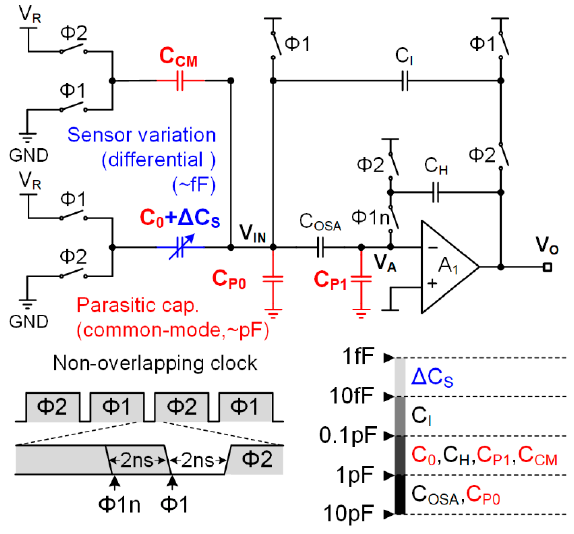
Figure 2. Schematic, timing diagram, and typical capacitance value of traditional switched-capacitor capacitance-to-voltage converter (SC-CVC) of readout circuit.